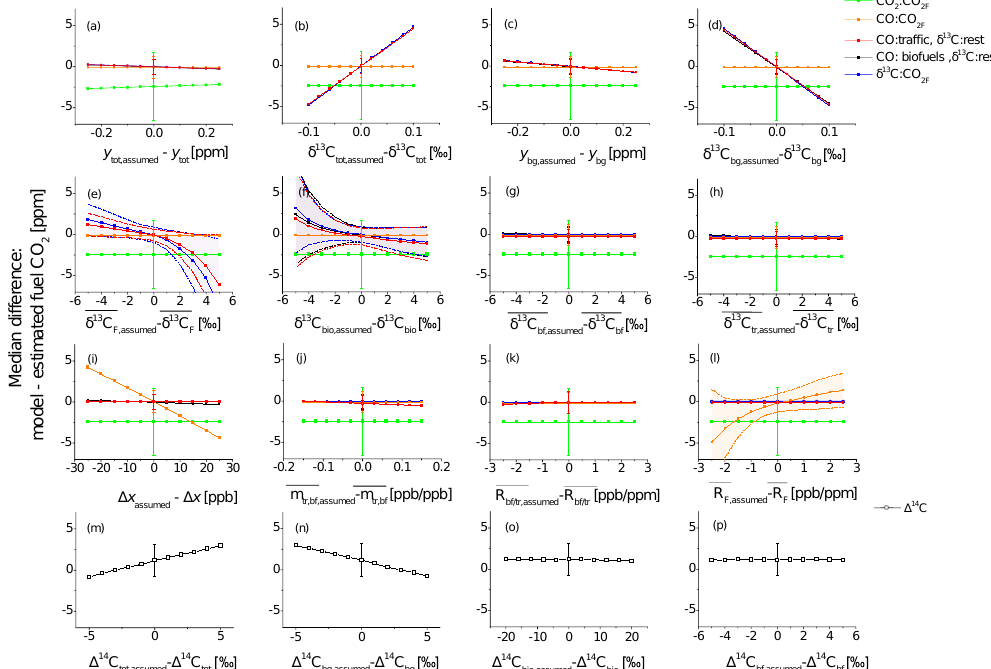
Figure 4. Sensitivity analysis: median difference between the modeled fuel CO 2 and the tracer-based estimated fuel CO 2 value ( y axis) at a typical urban site (Heidelberg) when using parameters/variables for fuel CO 2 estimation (“assumed”) deviating from the correct parame- ters/variables used in STILT. The error bars given at x = 0 (assumed value = model value) denote the interquartile ranges (IQR) for all x positions. If the IQRs vary depending on the assumed value, the errors (IQRs) are drawn as shaded areas.